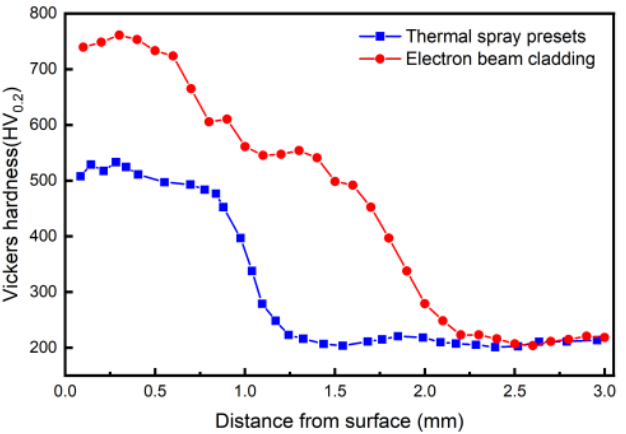
Figure 12. Section depth direction